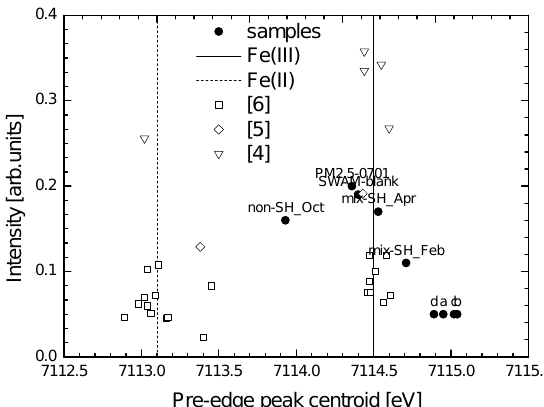
Figure 2. XANES pre-edge features fit parameters scatterplot: comparison between samples and standard Fe(II) and Fe(III) compounds studied in previous literature ([29,30]). Legend for SH_Dec 2014 samples: (a) HVS PM 10 30.11.2014, (b) HVS PM 10 01.12.2014, (c) SWAM PM 2.5 30.11.2014, (d) SWAM PM 2.5